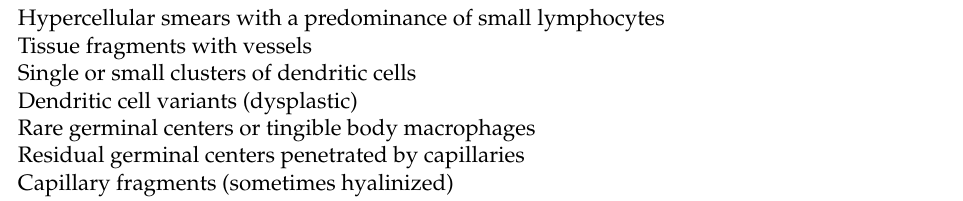
Table 4. Main cytological features of hyaline vascular (hypervascular) Castleman